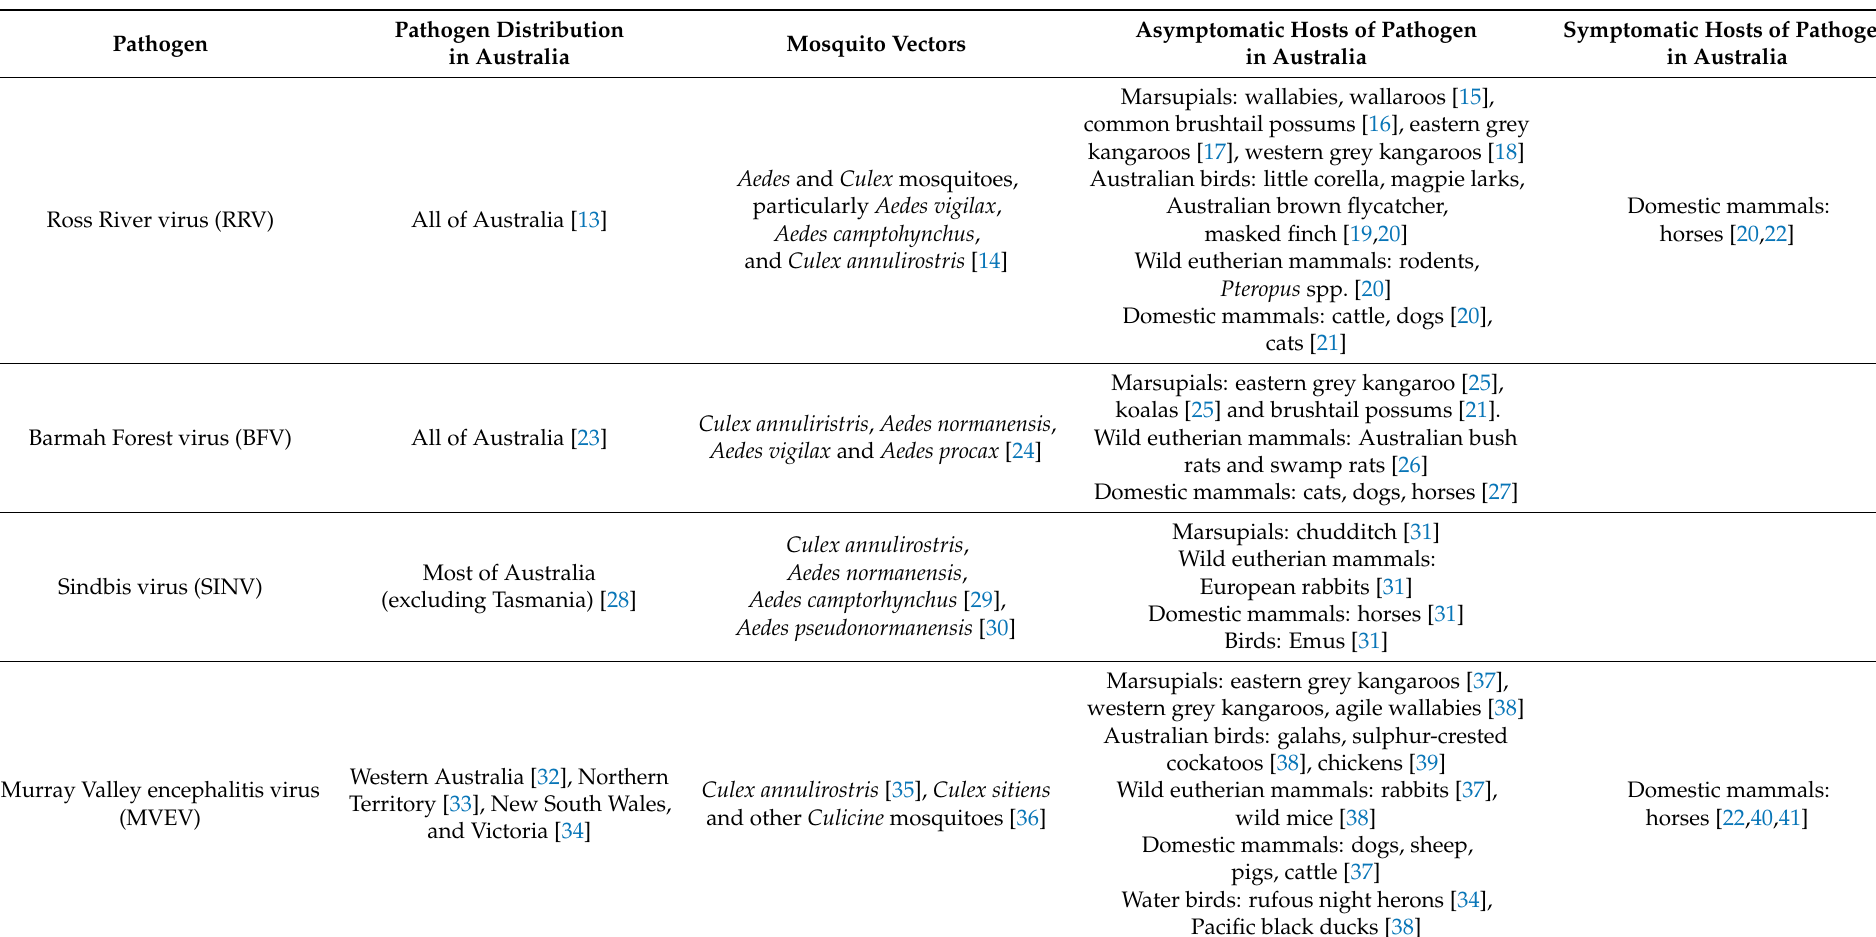
Table 1. A summary of pathogen, pathogen distribution, mosquito vectors, and symptomatic a and asymptomatic b host distribution in Australia. Dengue and Rift Valley fever are not listed as there have been no known non-human vertebrate hosts in